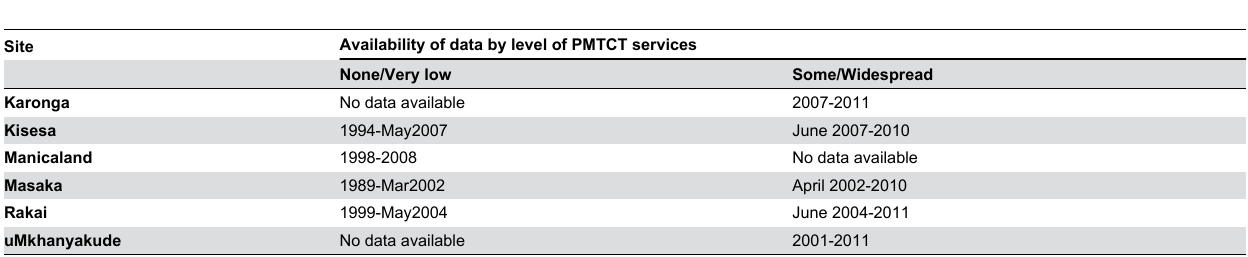
Table 1. Data available from sites by periods in which availability of PMTCT was low medium and high.